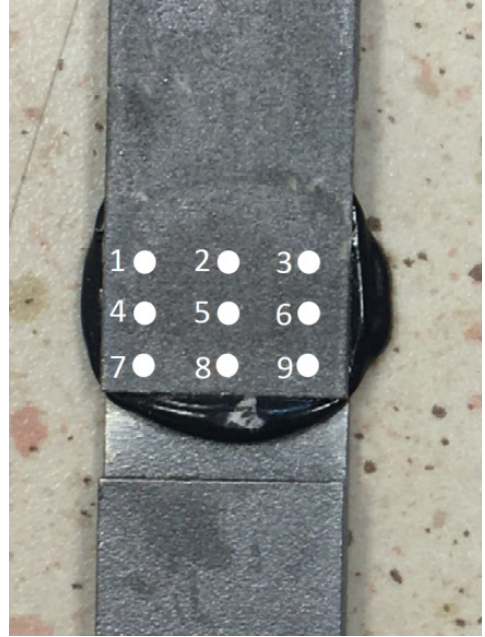
Figure 5. View of the sample with the measuring grid.